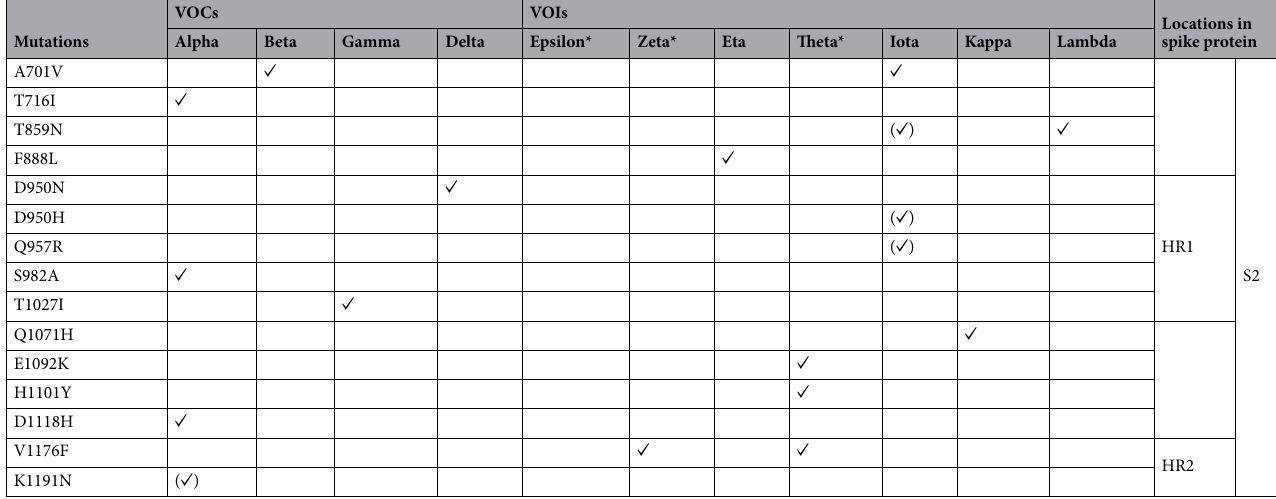
Table 1. Spike protein mutations among SARS-CoV-2 variants of concern (VOCs) and variants of interest (VOIs). The cells with ticks and bracketed ticks denote high and partial prevalence in the lineages, respectively. Variants with asterisks are former VOIs. HR1 and 2, heptad repeats 1 and 2; NTD, N-terminal domain; RBD, receptor-binding domain; S1 and S2, subunits 1 and 2; SP, signal